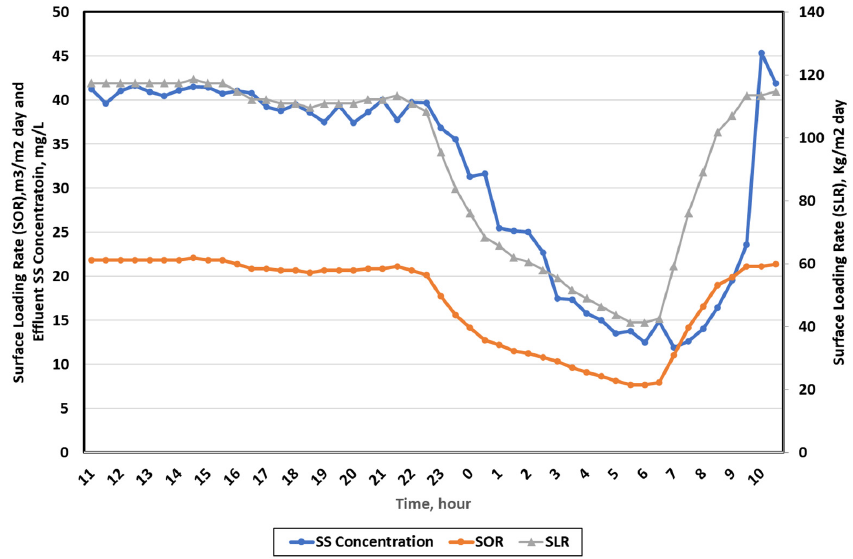
Figure 8. Simulation results of hourly secondary effluent SS concentrations and corresponding hourly SORs and SLRs at the secondary clarifier at plant A.